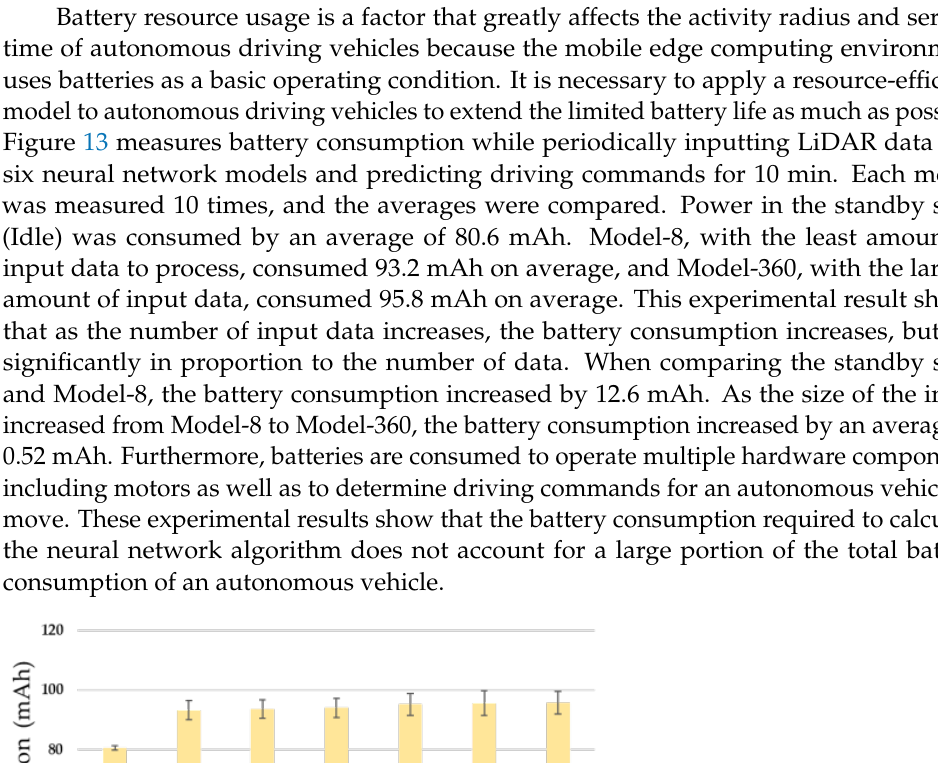
Figure 12. Response Time of six Neural Network Models.